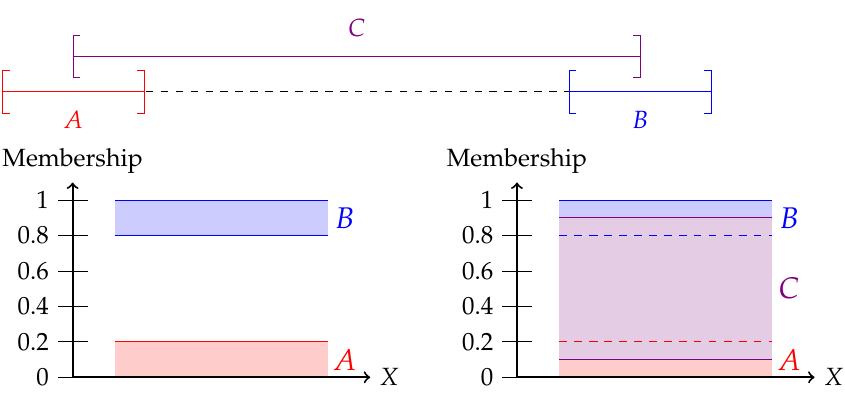
Figure 16. Distance between different